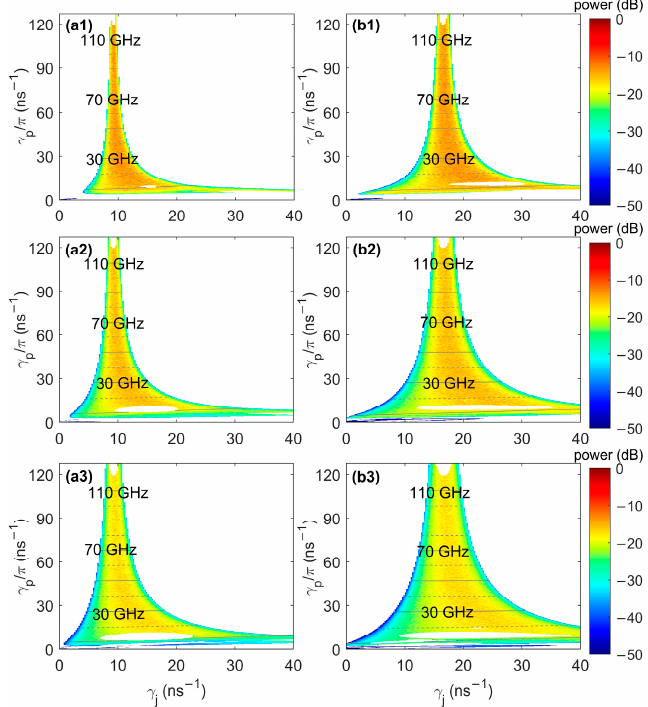
(cid:16) (cid:17) γ j , γ p plane. ( a1 , b1 ) α = 2,